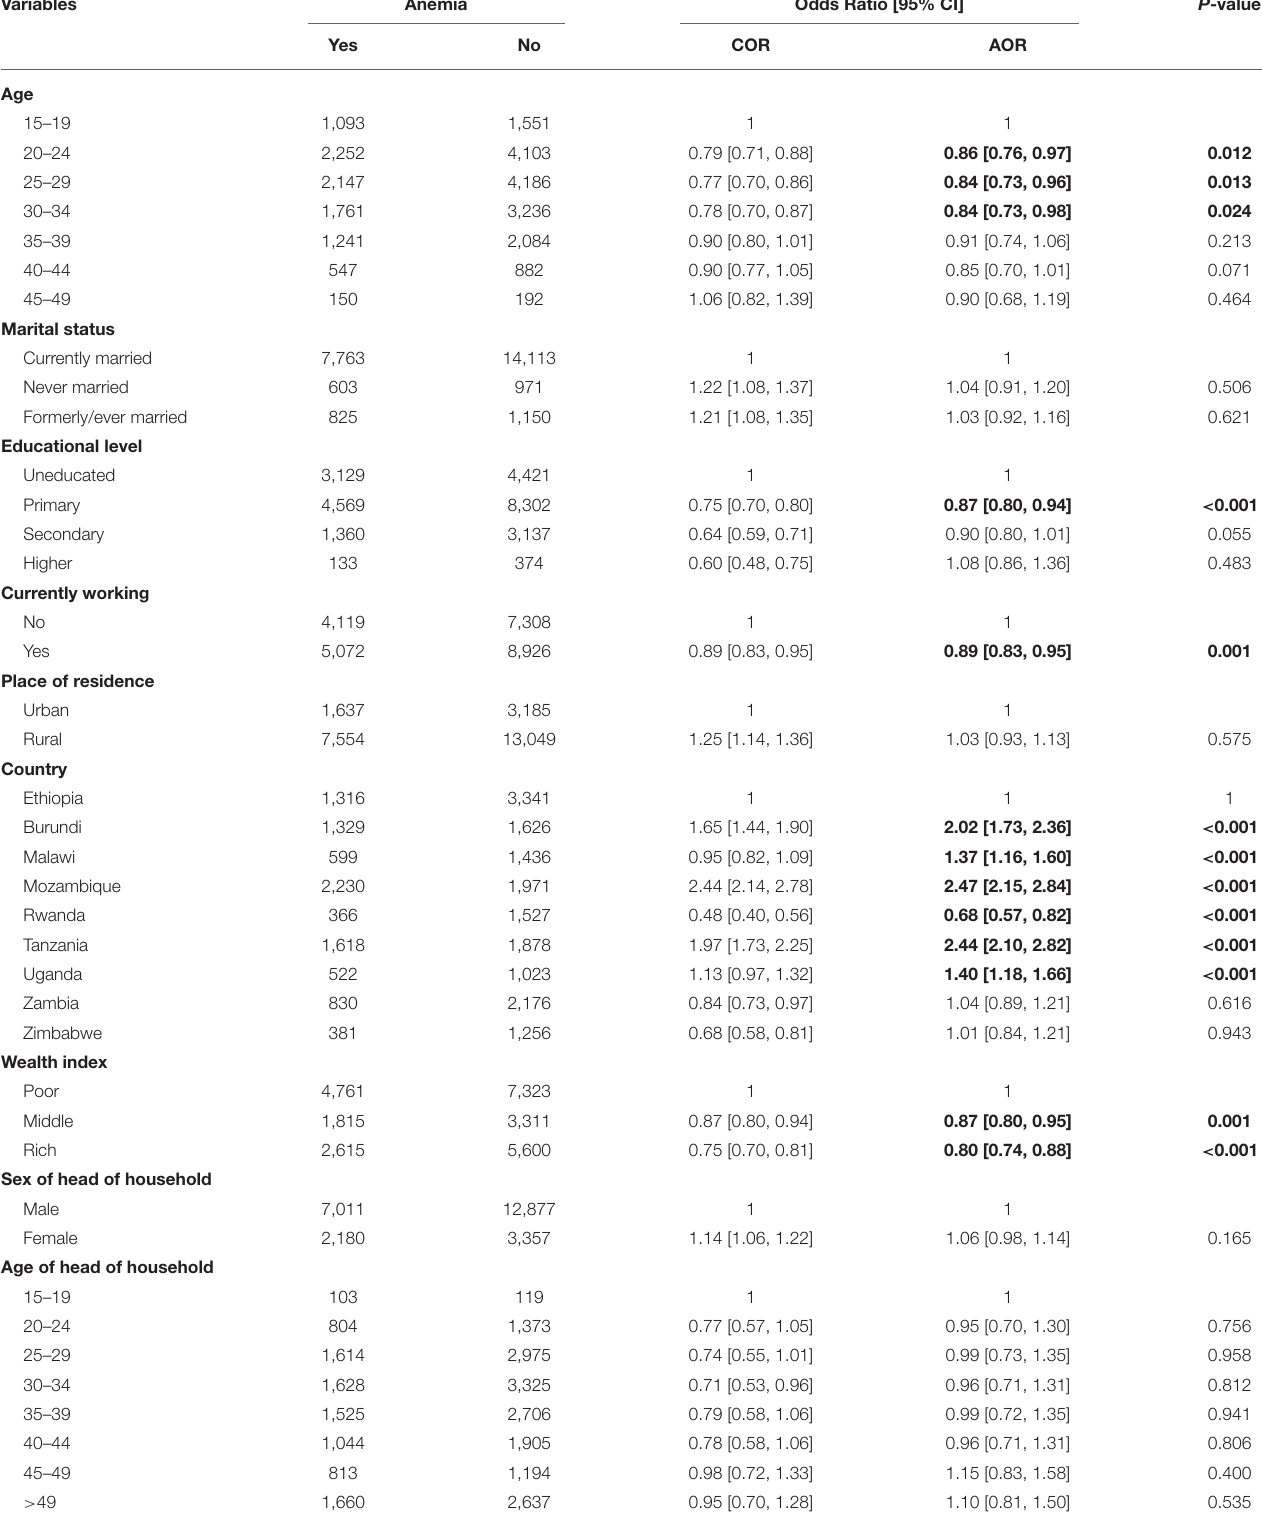
TABLE 4 | Bi-variable and multi-variable mixed effect GLM analysis of anemia among lactating mothers in East African countries, 2021.